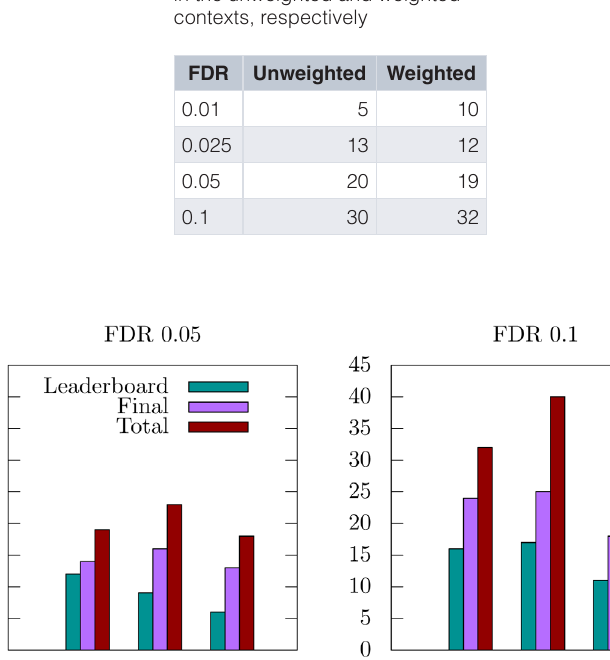
Table 2. Number of significant disease modules detected. over